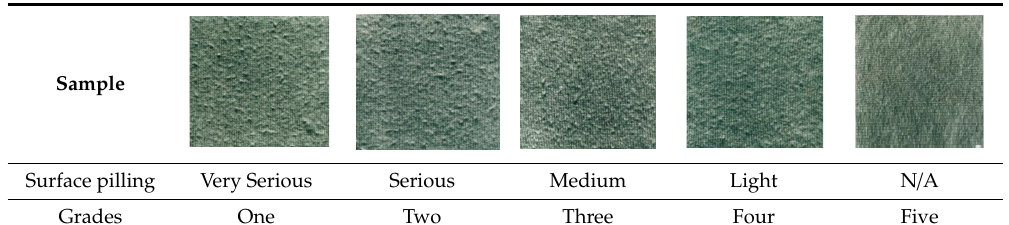
Table 1. Five grades of pilling detection.